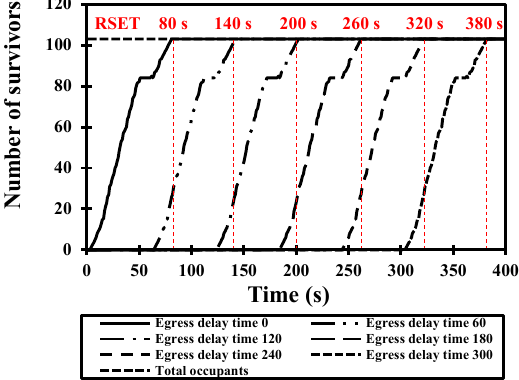
Figure 7. Simulation results (total evacuees = 103).